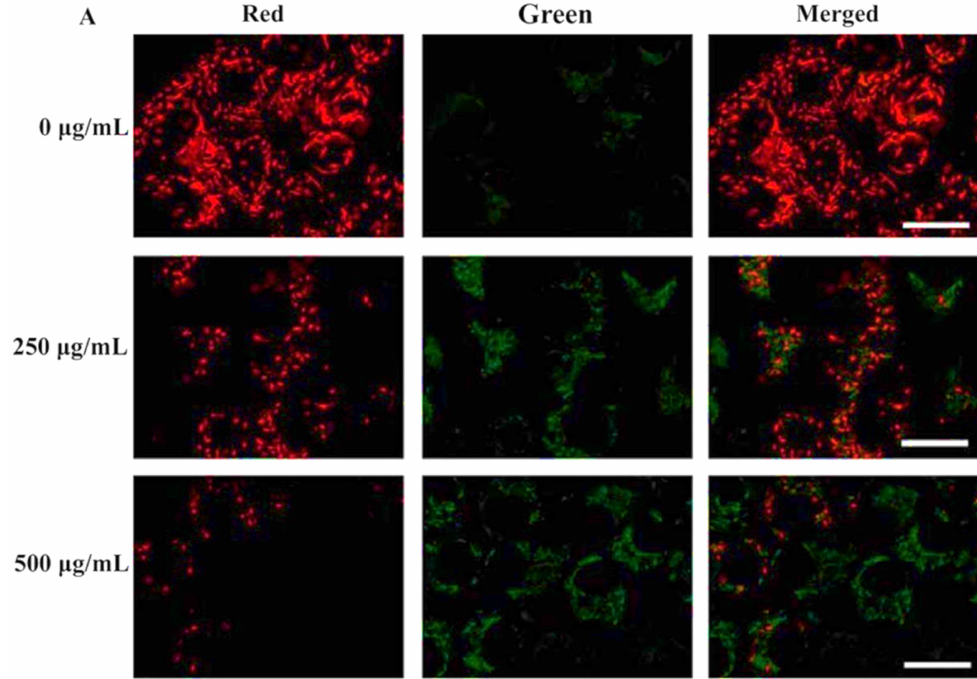
Figure 5. Assessment of mitochondrial membrane-potential in A549 after HAp-treatment. Con- focal micrographs of JC-1-labeled A549 cells after 48 h of treatment with HAp NPs with rod-like morphology are shown. The red signal corresponds to the JC-1 aggregates that are formed in a mitochondrial membrane potential-dependent manner. The green signal corresponds to the JC-1 monomers emission. Scale bar: 20 µ m. Figure republished from [33] with permission from the American Chemical Society. Copyright ©